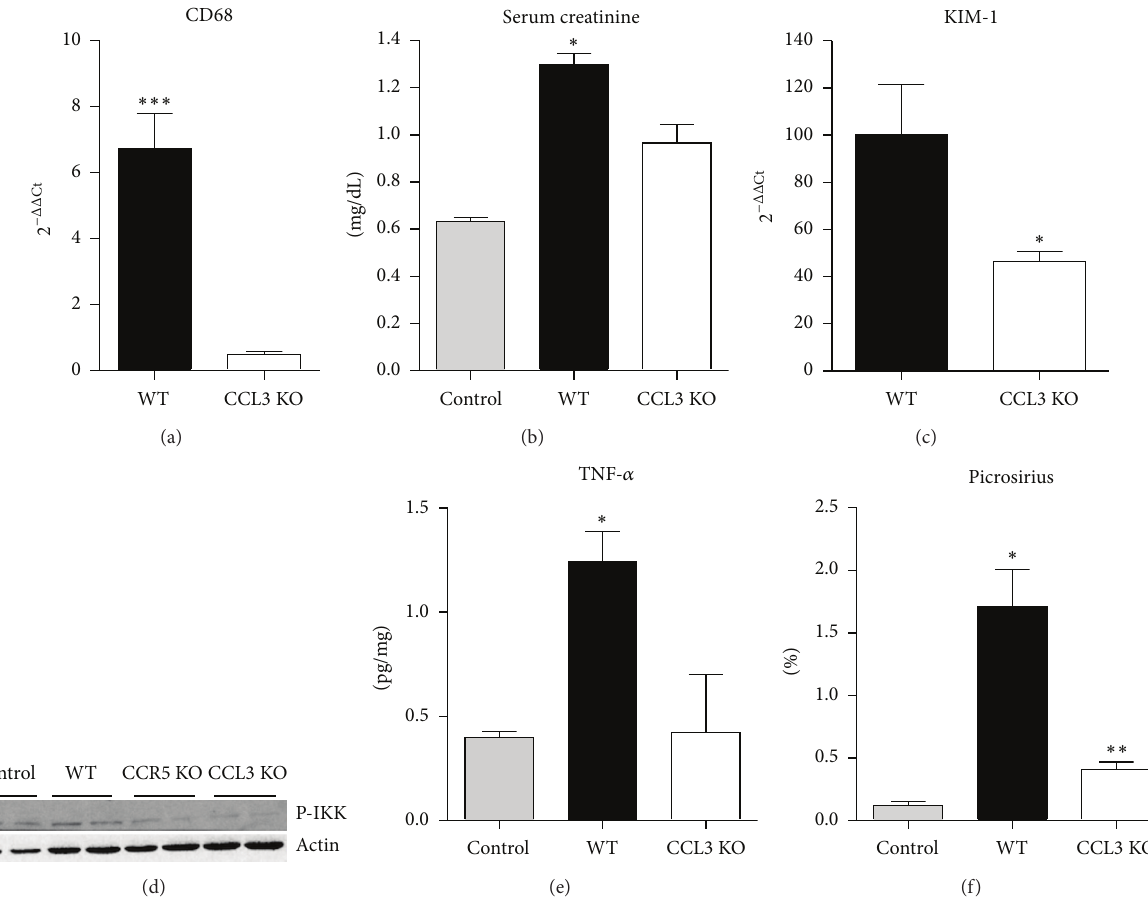
Figure 7: CCL3 KO animals also show a better outcome after adenine-induced TIN. (a) CD68 expression in WT and CCL3 KO animals ( ∗∗∗ 𝑃 < 0.001 versus CCL3 KO group). The renal function was evaluated by serum creatinine levels (panel (b), ∗ 𝑃 < 0.05 versus control and CCL3 KO groups) and KIM-1 transcripts levels (panel (c), ∗ 𝑃 < 0.05 versus WT). (d) Western Blotting for p-IKK was performed in control, WT, and KO groups. (e) Protein levels of TNF- 𝛼 in renal tissue ( ∗ 𝑃 < 0.05 versus control and CCL3 KO groups). Fibrosis was evaluated by picrosirius staining and the graphic quantification can be observed in panel (f) ( ∗ 𝑃 < 0.01 versus Control and CCL3 KO groups and ∗∗ 𝑃 < 0.05 versus